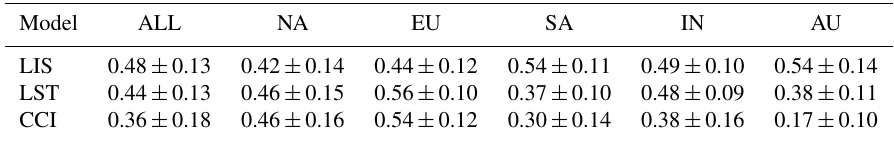
Table 2. Summary of the TC error variance analysis, reporting the spatial average ( ± standard deviation) values observed over each macro- region.